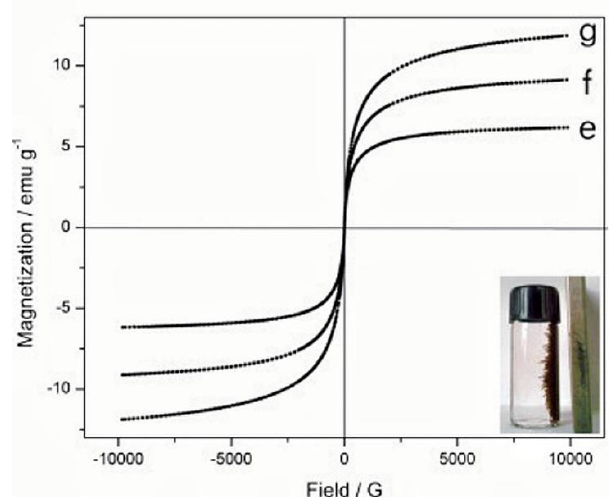
Figure 4. The magnetic hysteresis loops of (e) MWS 1 , (f) MWS 2 , and (g) MWS 5 at 298 K. Inset: The photograph of MWS 5 with an external magnetic field [95]. Reprinted with permission from Ye Tian et al. (2011). Copyright 2011, Elsevier.